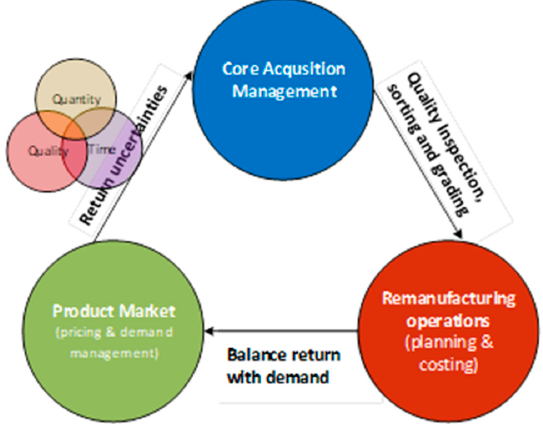
Figure 1. The uncertainties in remanufacturing (adapted and extended from Wei et al. [24].